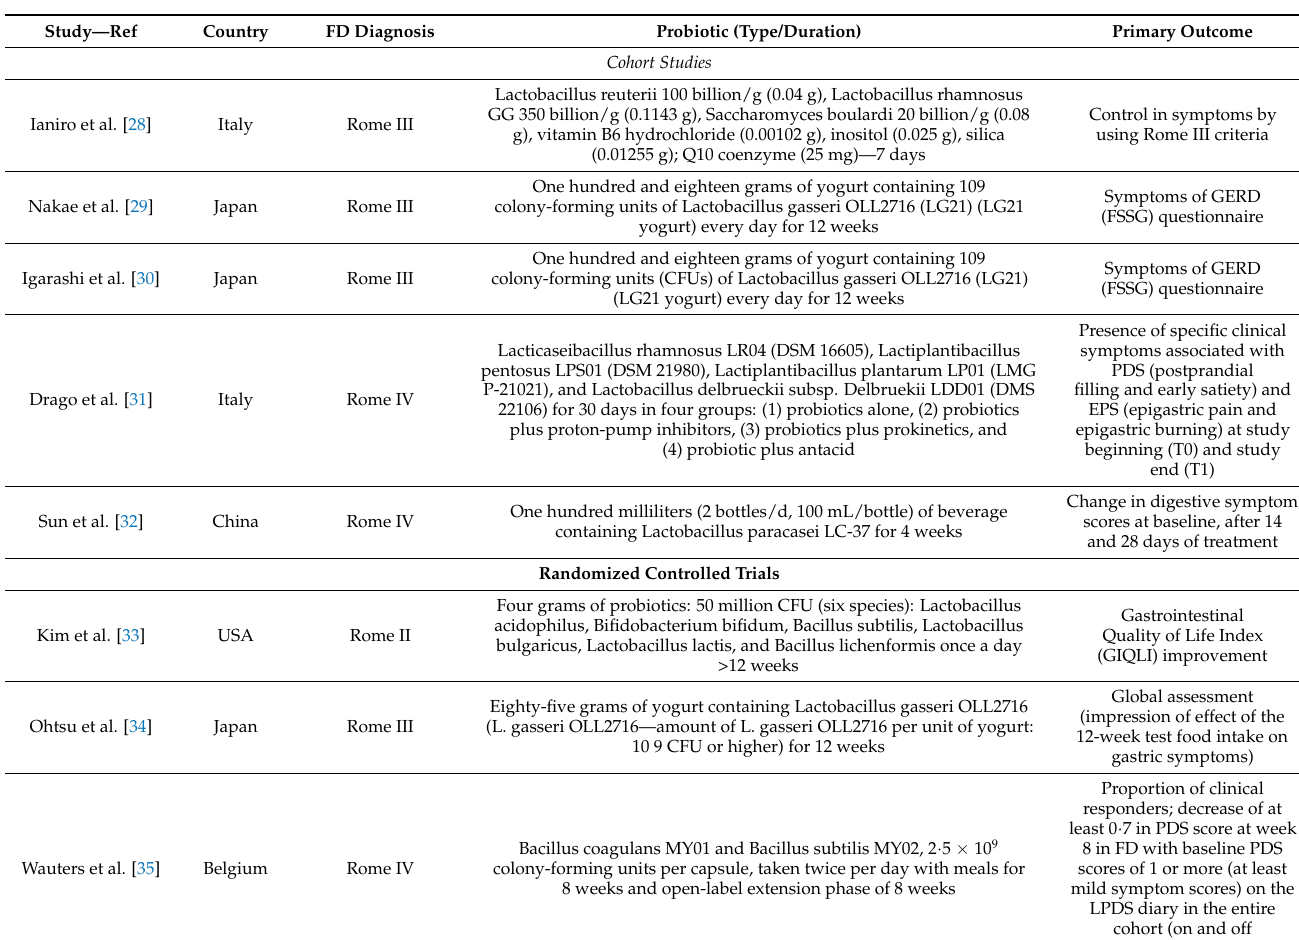
Table 1. Studies assessing the efficacy of probiotics in functional